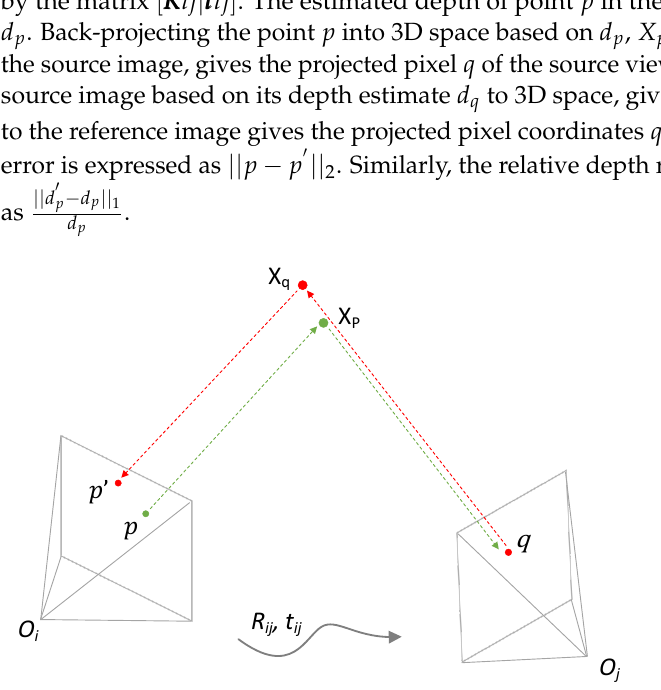
Figure 4. To be specific, the image i and j are related by their relative position represented by the matrix [ RRRij | tttij ] . The estimated depth of point p in the reference view is denoted as d p . Back-projecting the point p into 3D space based on d p , X p is obtained. Projecting X p to the source image, gives the projected pixel q of the source view. Back-projecting the q in the source image based on its depth estimate d q to 3D space, gives the point X q . Projecting X q (cid:48) to the reference image gives the projected pixel coordinates q . The coordinate reprojection (cid:48) || error is expressed as || p − p 2 . Similarly, the relative depth reprojection error is expressed || d (cid:48) p − d p || 1 as d